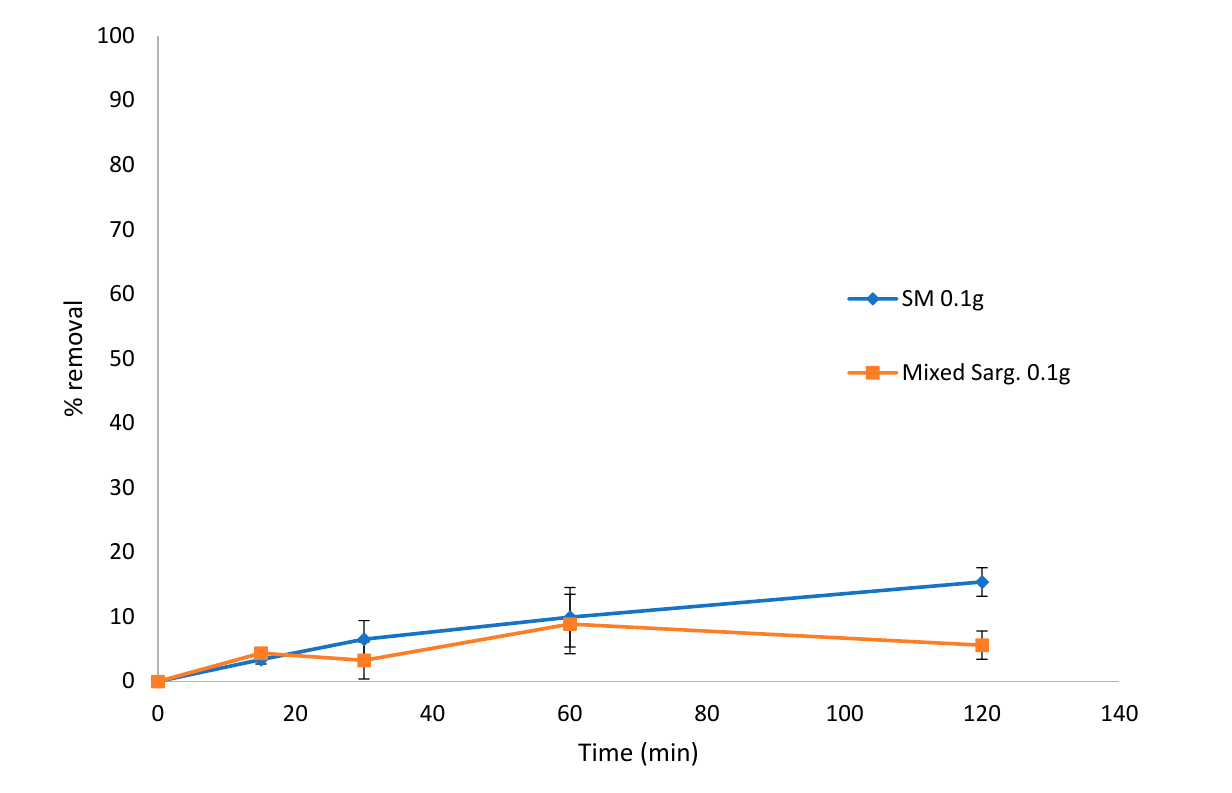
Figure 6. Biosorption of congo red over 120 min by Sargassum muticum (SM) and mixed Sargassum spp. in 0.1 g and 10 mg L − 1 (80 mL) dye solution. Standard deviation n = 3.